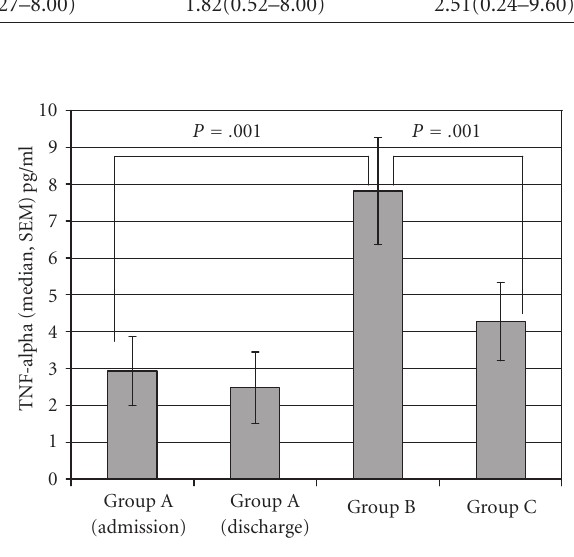
Figure 1: Serum levels (median, SEM) of IL-1 β in the three study groups.